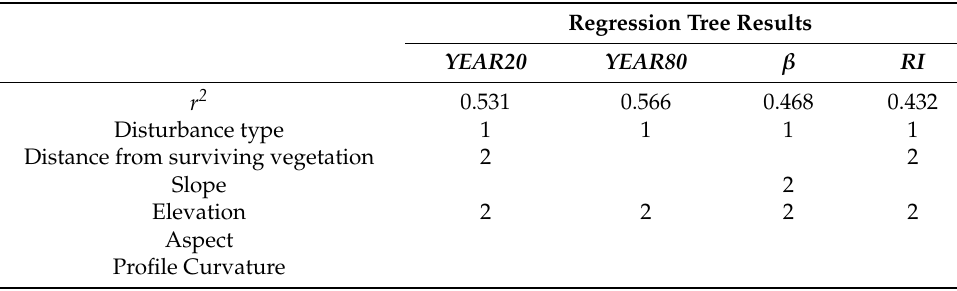
Table 5. r 2 values and top explanatory variables from the first two splits of the regression